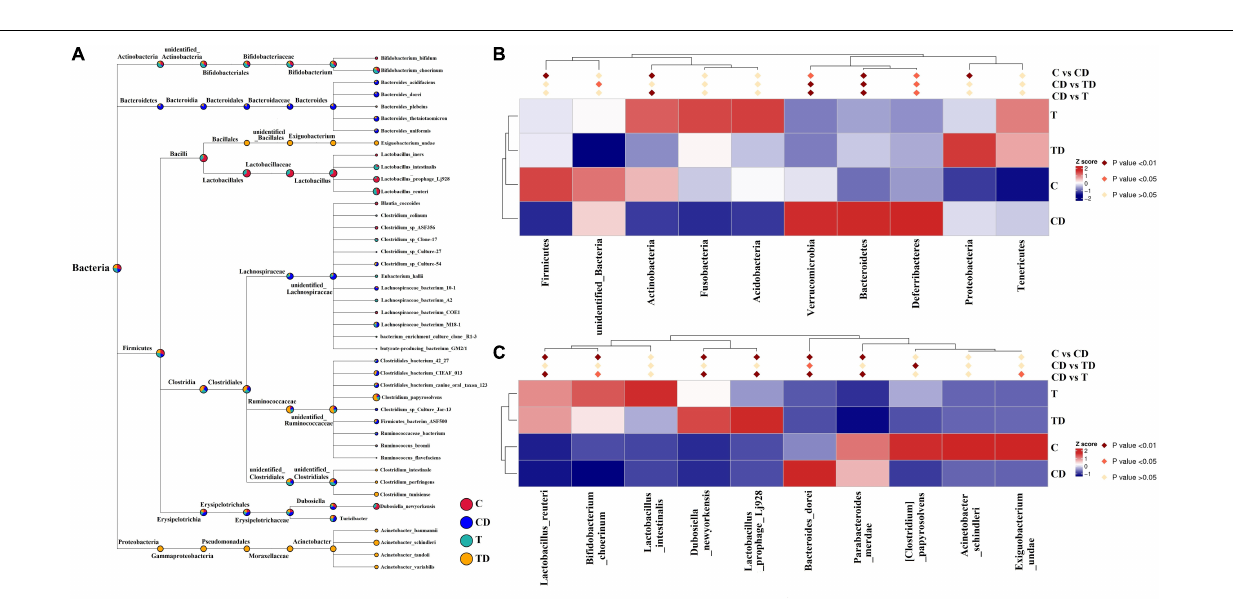
Frontiers in Microbiology |